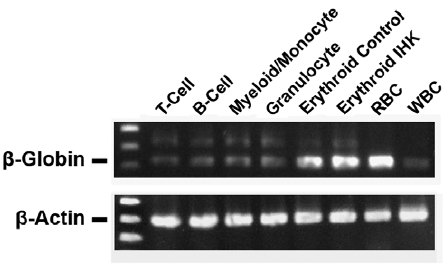
Figure 6. Increased b -globin transcript is detectable in non- erythroid progeny of IHK-transduced CD34 + cells. Twenty ng of total RNA was used for RT-PCR specific for spliced b -globin transcript and spliced b -actin. RNA from adult RBCs and erythrocyte-depleted adult WBCs was used as